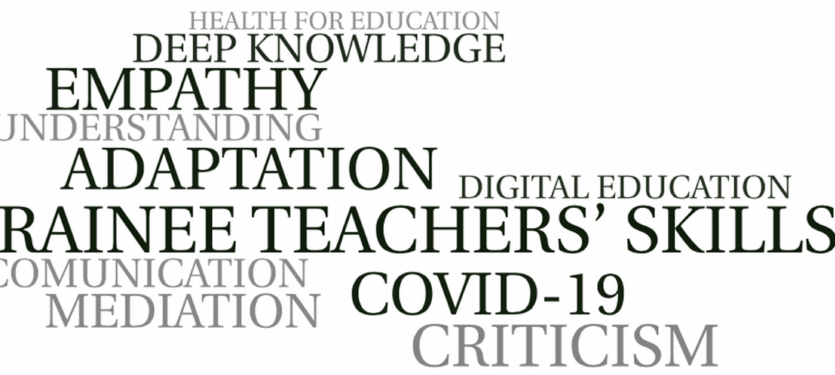
Figure 8. World cloud alluding to arguments in relation to trainee teachers’ skills. Self-made